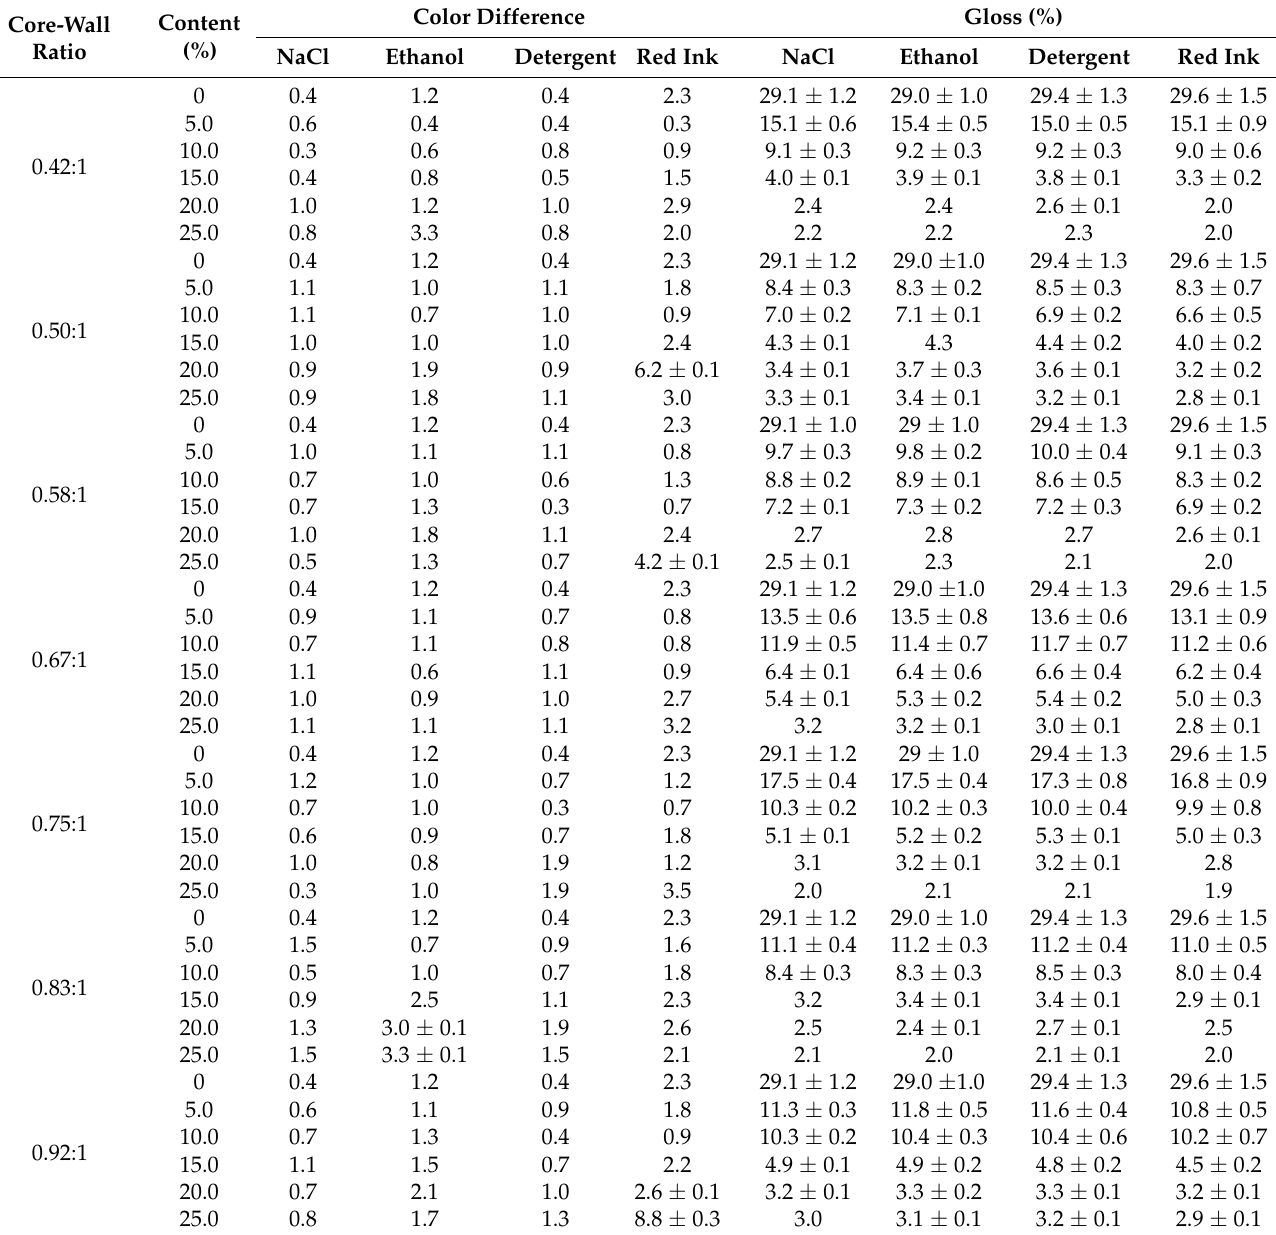
Table 6. The change in optical properties of water-based topcoat paint film after liquid